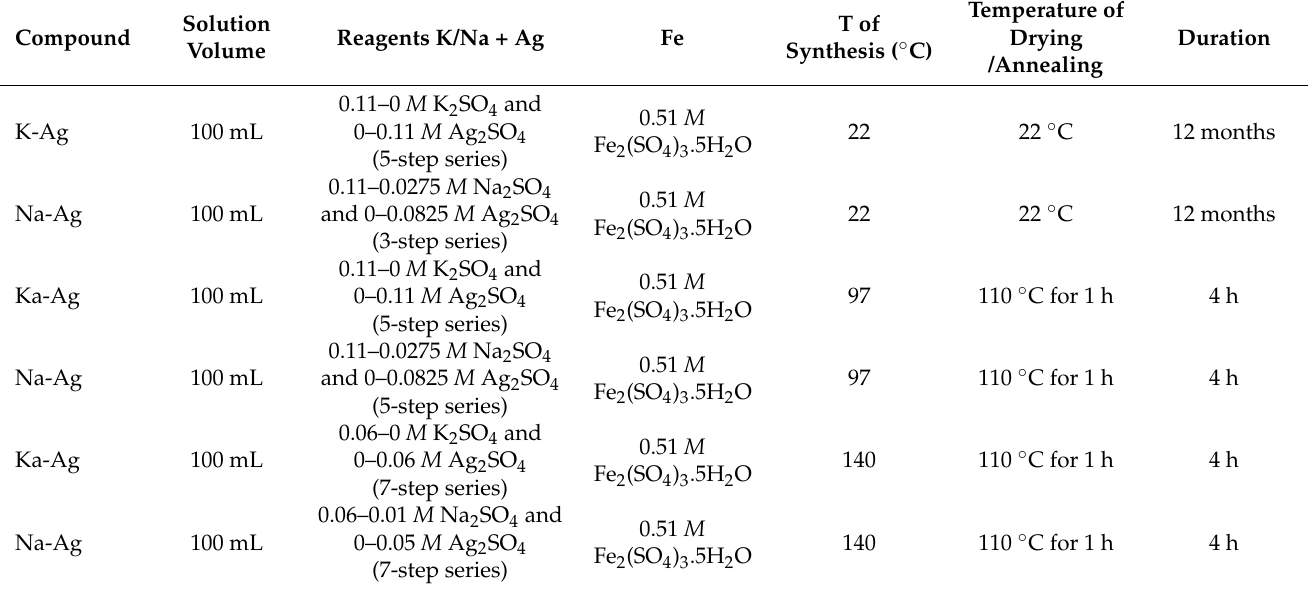
Table 1. Conditions of the synthesis of synthetic jarosite group